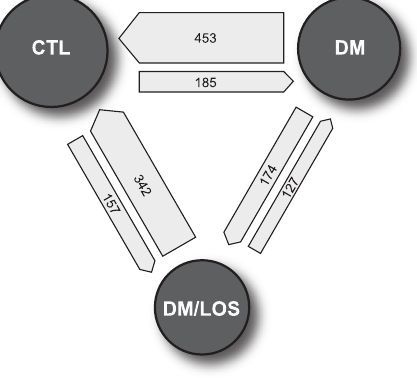
Figure 3. Gene expression changes by condition. Shown are statistically significant changes in gene expression between pairs of experimental conditions (CTL, non-diabetic state; DM, diabetic; DM/LOS, diabetes + losartan treatment). The area of the circle representing each condition is proportional to the total number of significant expression changes involving that condition (e.g., 453 + 185 + 342 + 157=1137 total for CTL). The width (thickness) of each arrow is proportional to the number of changes represented, and the direction of the arrow points to the condition in which expression is greater. For example, there were 453 gene products for which renal mRNA expression was greater under control conditions than in the diabetic state (or, re-stated, 453 gene products for which expression was lower in the diabetic state than in the non-diabetic state). The smallest number of differences was seen in the DM vs . DM/LOS dyad and the greatest number in the CTL vs. DM